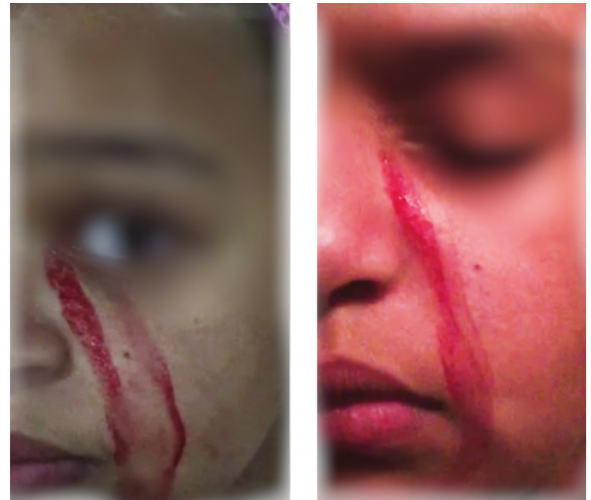
Figure 1: Unilateral hematohidrosis of left facial side observed on two separate